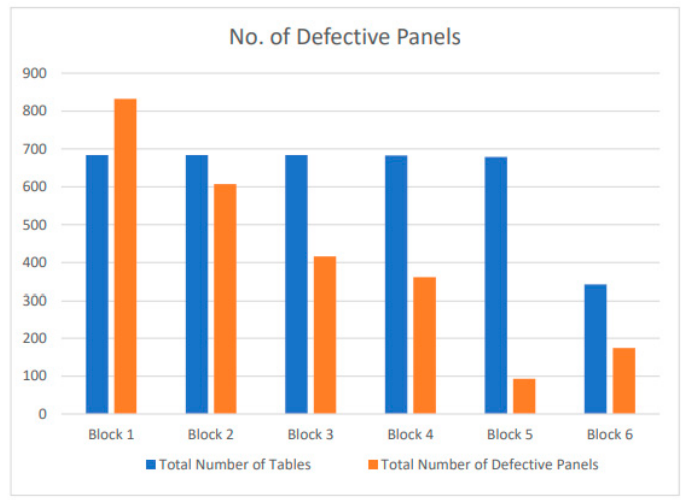
Figure 10. No. of defective panels. The statistical graphic analysis of the number of panels in its block versus the number of defective panels in the corresponding block.